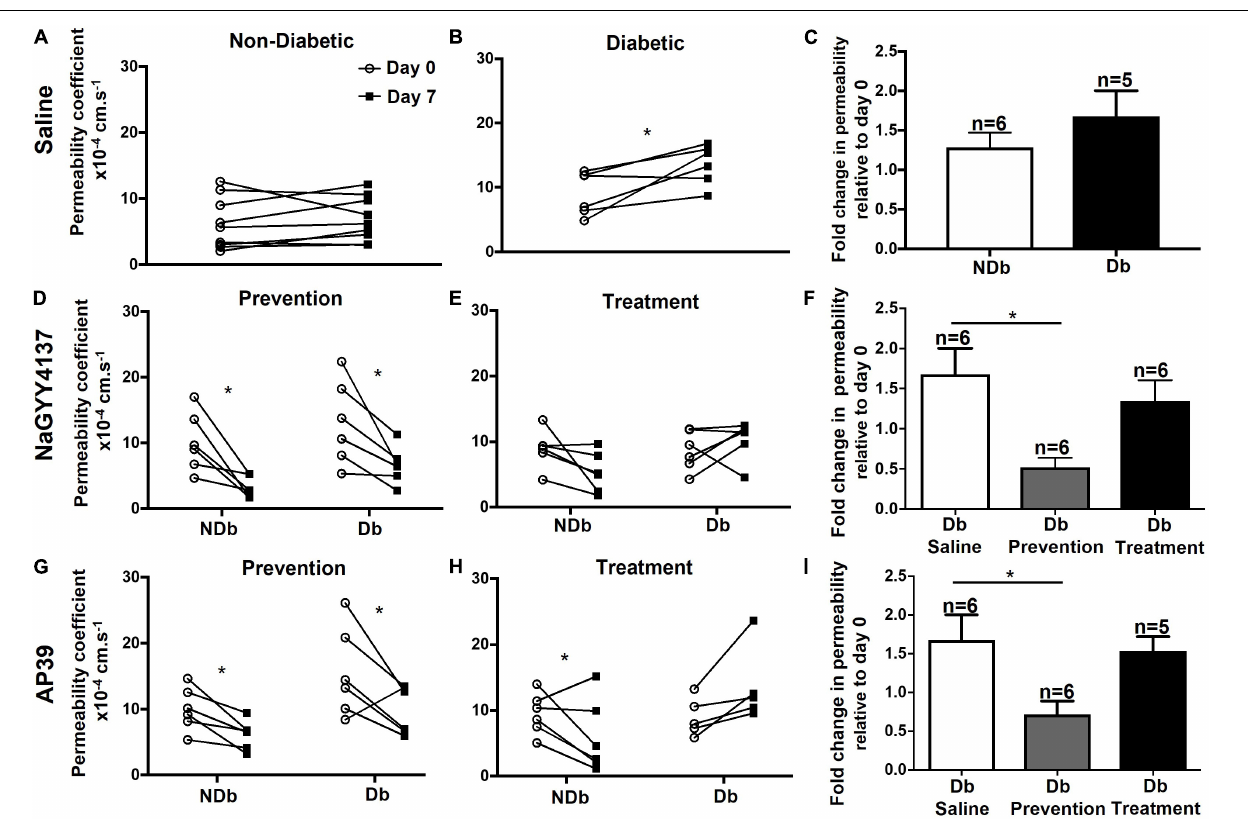
FIGURE 5 | Ocular administration of the slow-release H 2 S donors reduced retinal permeability in chemically induced diabetic rats. Type I diabetes was successfully induced in rats following a single dose of STZ and animals were maintained for 1 week without insulin supplementation. Retinal vascular leak was measured on day 0 and day 7 in non- and diabetic animals following treatment. No observed increases in retinal permeability were measured on day 7 in non-diabetic animals treated with saline (A,C) . In diabetic animals treated with saline a significant (* p ≤ 0.05) increase in retinal permeability was measured on day 7 vs. day 0 (B,C) . NaGYY4137 and AP39 significantly (* p < 0.05, paired t -test) reduced retinal permeability in non- and diabetic rats (D,G,F) on day 7 when given as a single intraocular preventative dose, on day 0. In addition, NaGYY4137 and AP39 reduced retinal permeability in non-diabetic rats (E,F,H,I) when administered therapeutically (day 6). In diabetic rats, NaGYY4137 and AP39 stabilized retinal permeability on day 7 in rats with pre-existing diabetes (E,F,H,I)